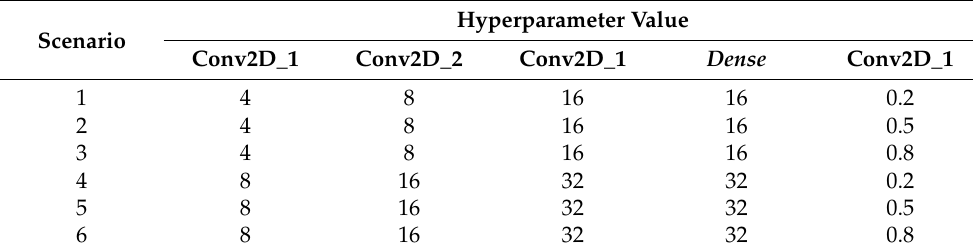
Table 4. Hyperparameter testing scenario [30,45–48].